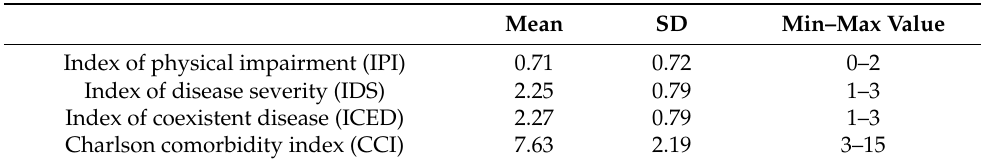
Table 2. Distribution of physical impairment indexes and the Charlson comorbidity index in patients on peritoneal dialysis ( n = 52).